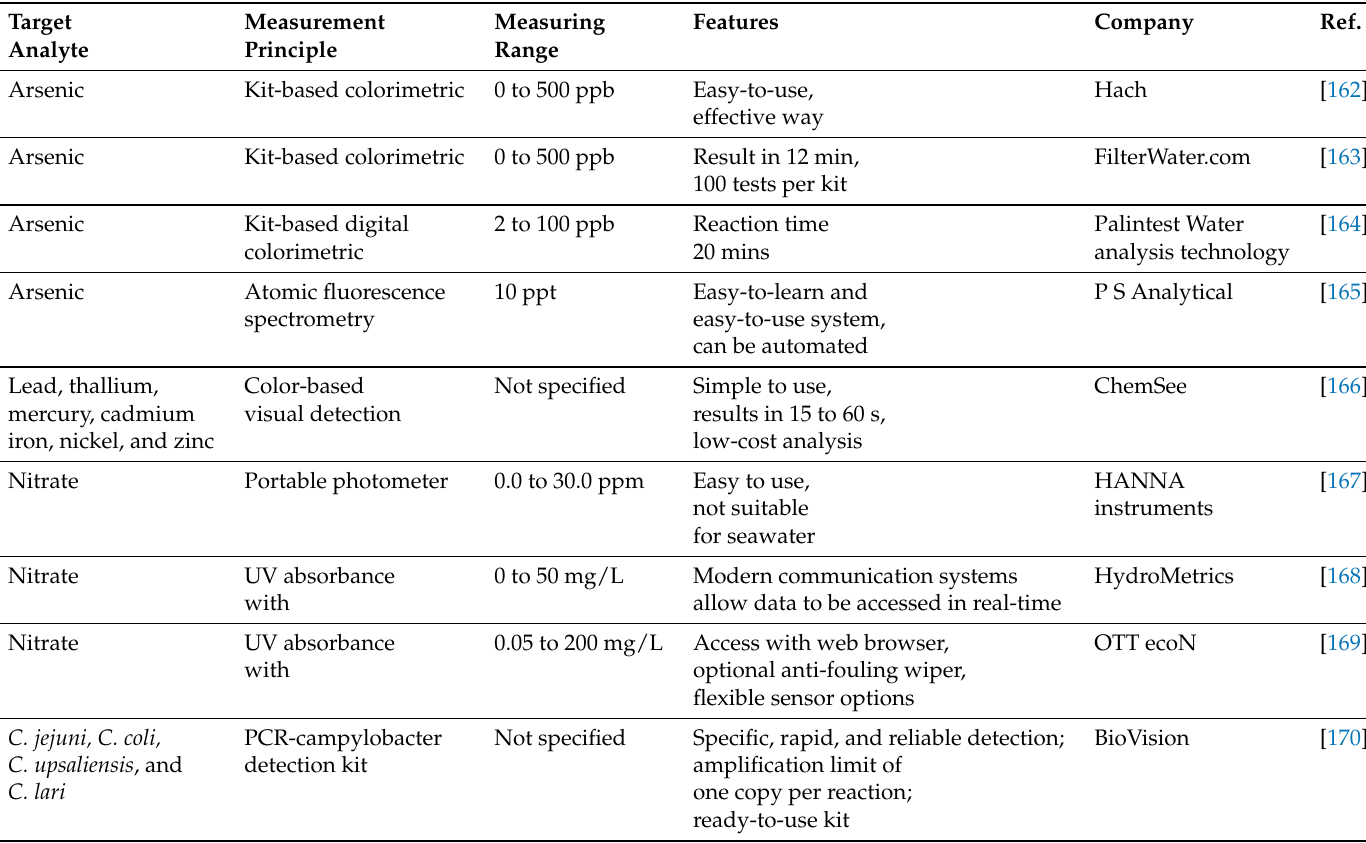
Table 5. Commercially available optical